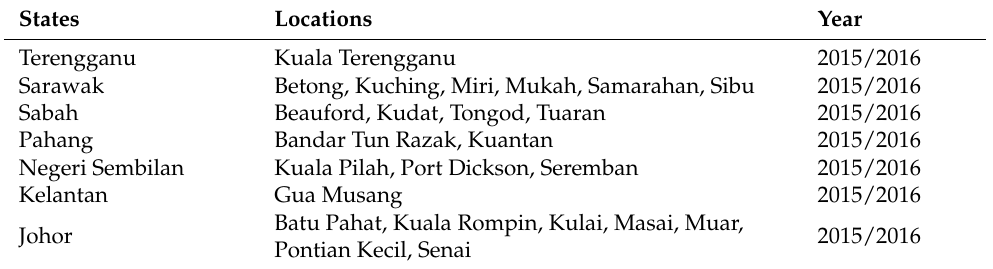
Table 1. The origins and date of collection of EBNs.